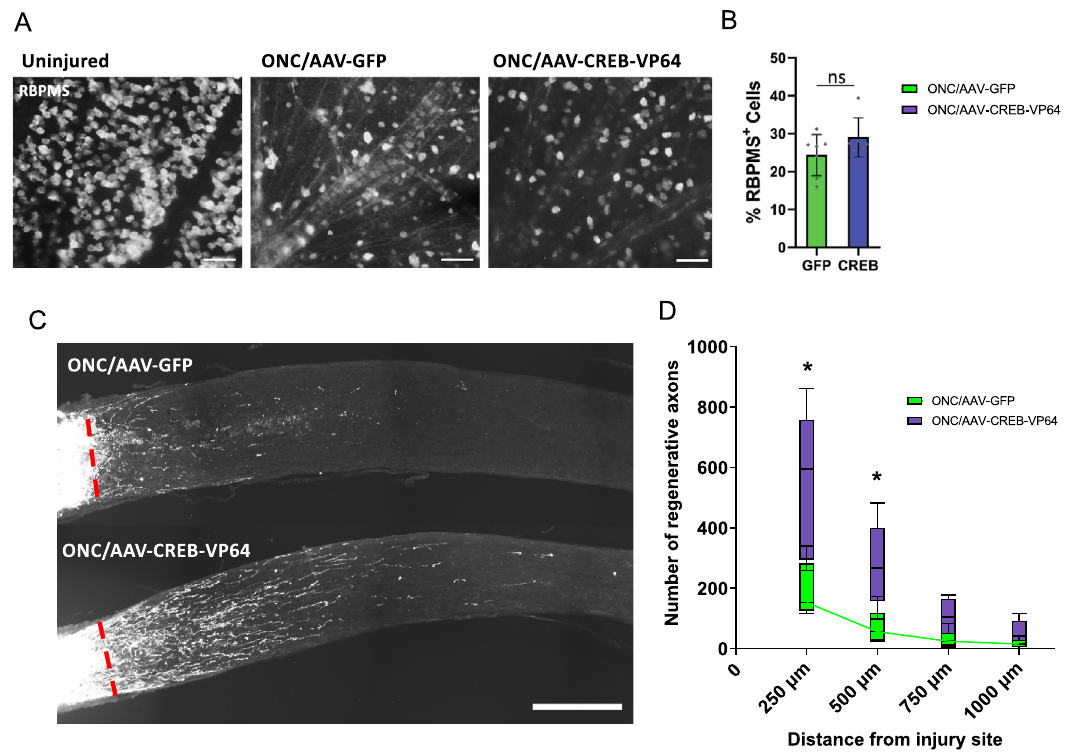
Figure 6. Overexpressing CREB-VP64 promotes optic nerve regeneration. (A) Representative images of retinal wholemounts stained for RBPMS (white) to label RGCs in the uninjured and injured condition 2 weeks after optic nerve crush. Scale bars = 50 µm. (B) Quantification of RGC survival 2 weeks post crush. Eyes injected with AAV2-CREB-VP64 (n = 7 animals) showed a trend towards increased survival compared to eyes injected with AAV2-GFP that was not significant (unpaired T-test. p = 0.1308). Error bars represent mean ± SEM. (C) Representative images of optic nerves sections showing regenerative fibers of mice intravitreally injected with either AAV2-CREB-VP64 or AAV2-GFP. Scale bar = 250 µm. (D) Number of regenerative fibers at various distances. Multiple t-test analysis with Holm-Sodak correction. * p adj < 0.05. n = 6 optic nerves per treatment. Four optic nerve sections were used to calculate the average for each nerve. Box-Whiskers plot was used where the box represents the 25th and 75th percentiles, the inside line represents the median, and the whiskers represents the largest and smallest